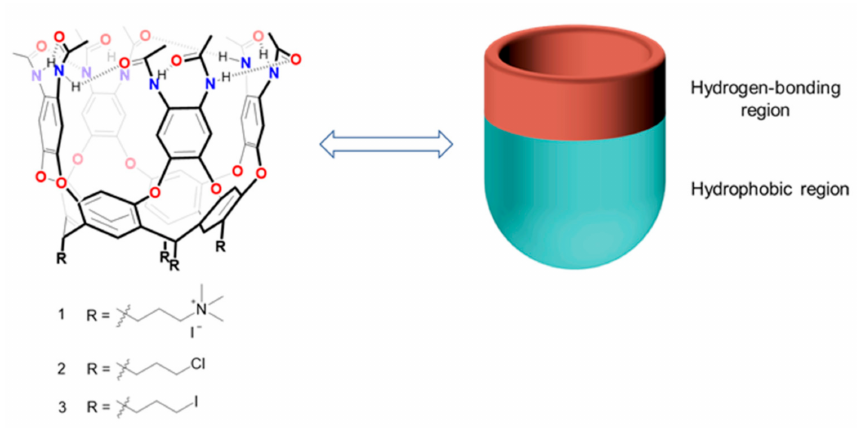
Figure 1. Chemical structures of the water-soluble cavitand 1 and its precursors. The cartoon highlights the environments inside the